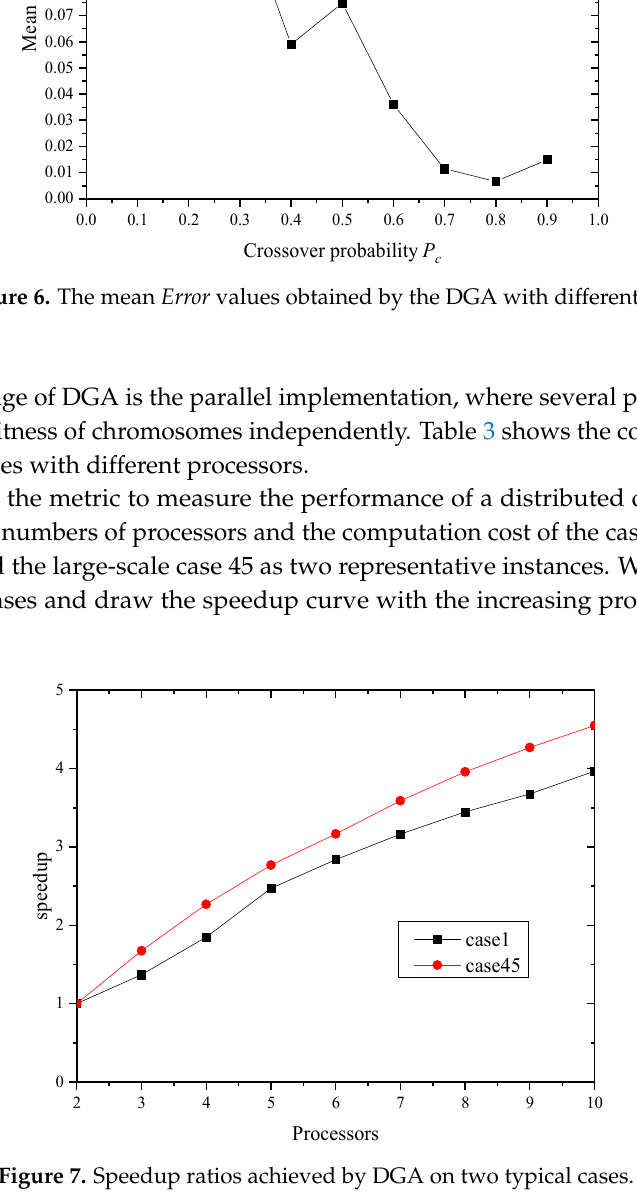
Figure 7. Speedup ratios achieved by DGA on two typical cases.